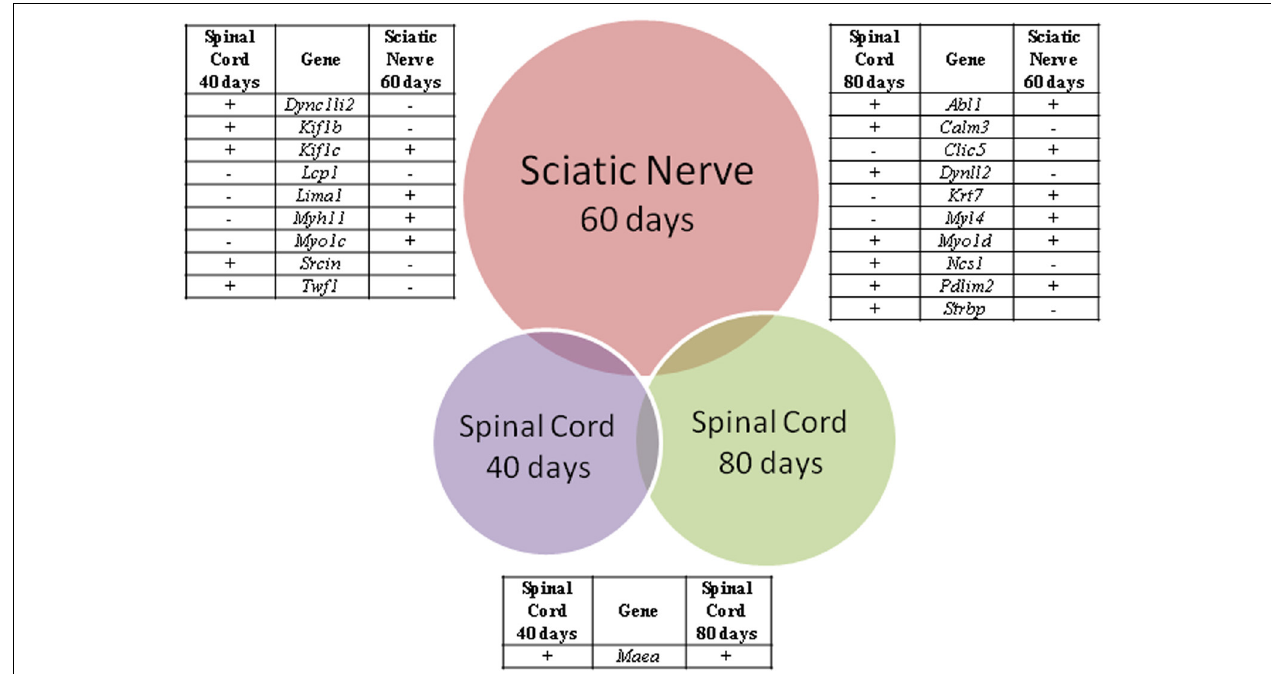
FIGURE 4 | Venn diagram of differentially expressed genes related to cytoskeleton analysis in spinal cords (40 and 80 days) and sciatic nerve (60 days) of SOD1 G93A animals compared to wild-type controls by means of microarray experiments. The enrichment cytoskeleton lists were obtained by means of DAVID tool based on Cellular Component Ontology, which identified 146 differentially expressed genes in the sciatic nerve from 60 days old